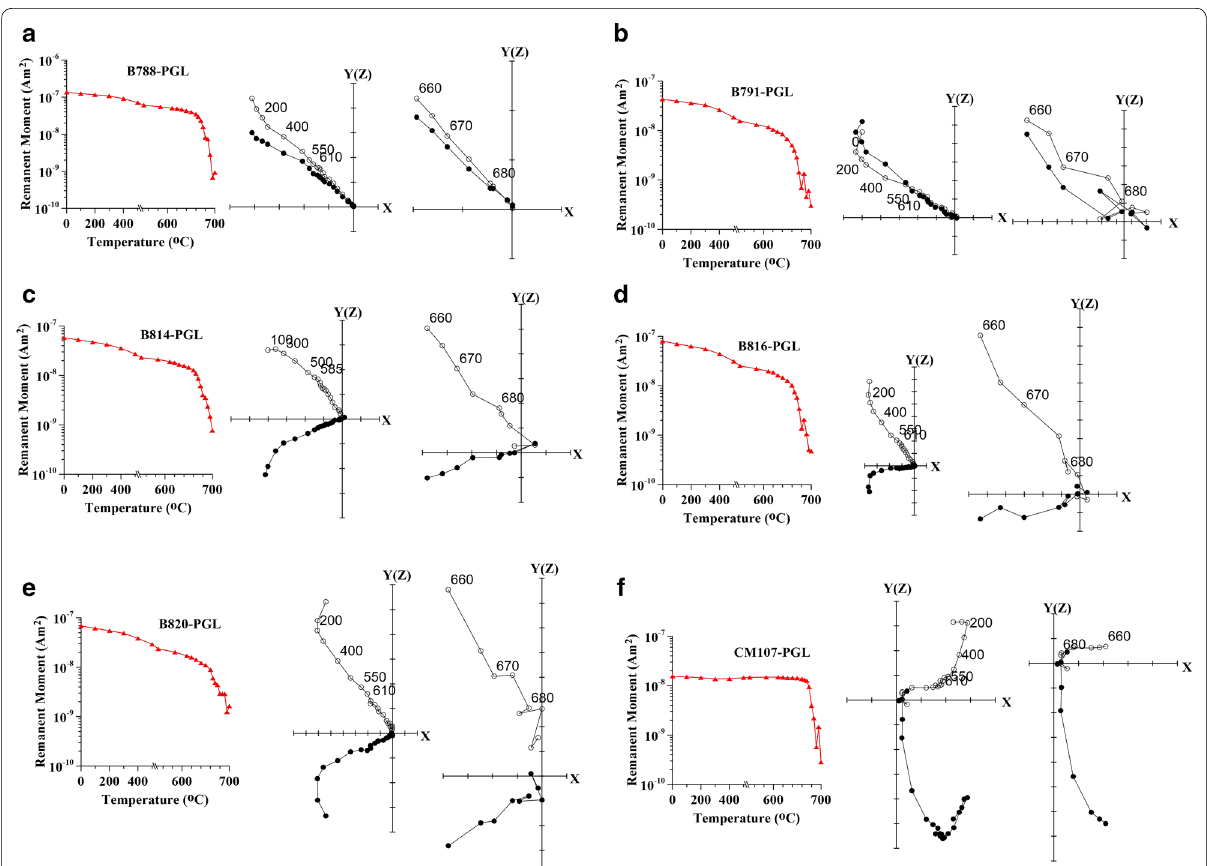
Fig. 10 Thermal decay curves and corresponding orthogonal plots of progressive thermal demagnetization of natural specimens. Solid (open) circles indicate projection on the horizontal (vertical)